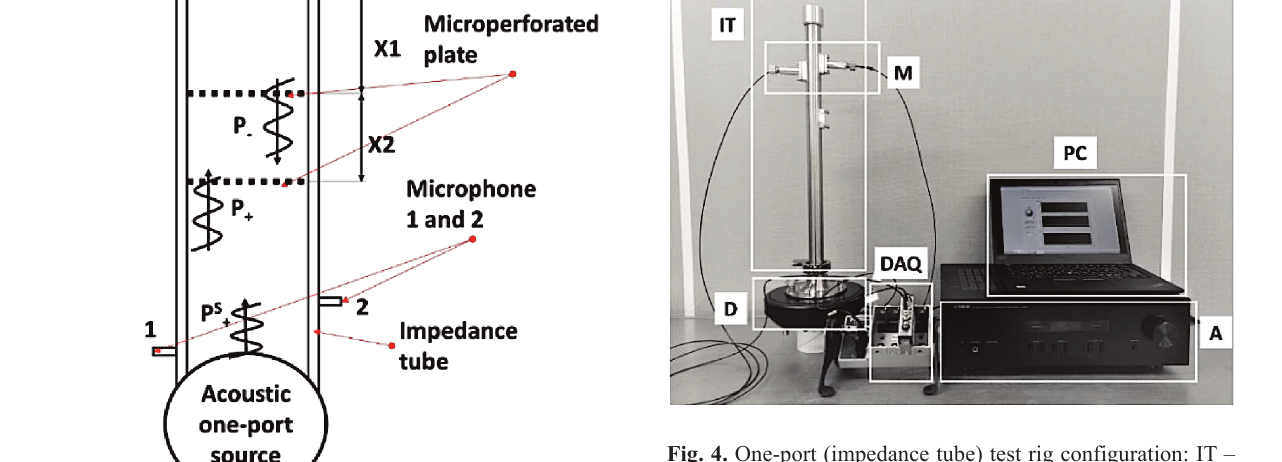
Fig. 4. One-port (impedance tube) test rig configuration: IT – impedance tube (inner diameter 28 mm); M – two 1/4" microphones; D – electro-dynamic drive (sound source); DAQ – data acquisition system; PC – computer; A – excitation signal